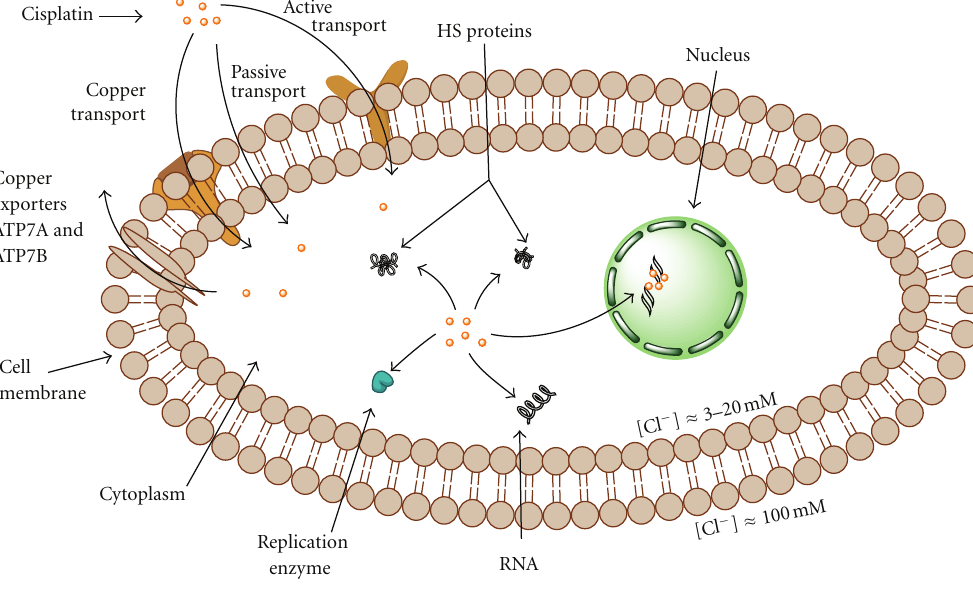
Figure 2: Cisplatin and the cell: transport/export and targets.